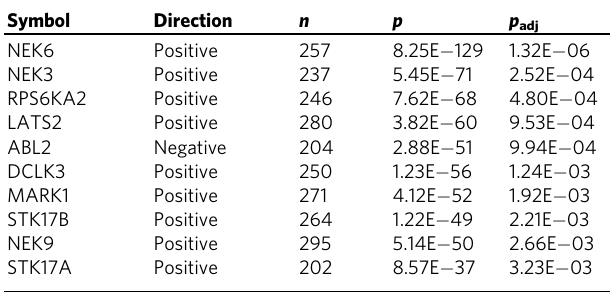
The table lists targets (symbol), whether those pairs are primarily positive or negative interactions (direction), the number of pairs they appear in ( n ), and the overall p -value computed by aggregating p -values from individual Wilcoxon Rank Sum tests (Fig. 5b) using the Brown ’ s method.Additionaladjustment formultiplehypothesistesting was performedusingthe Benjamini Hochberg method ( p adj